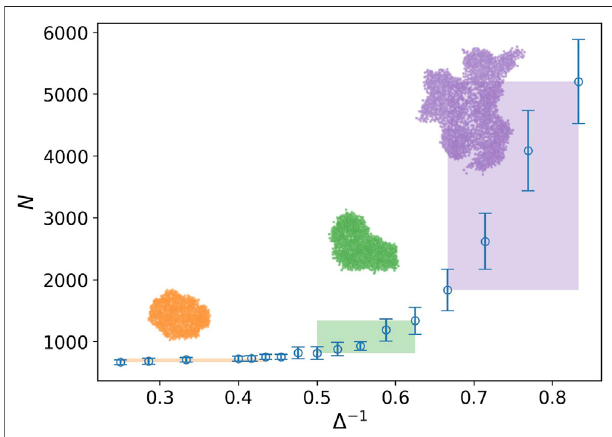
FIGURE 2 | Number of nodes against the inverse of attraction strength (blue circle), and the attraction range has a fi xed value, σ = 1.5. The error bars are the standard deviation of sampling over 20 simulation runs. Three regions with distinct behaviors are identi fi ed by the rectangles. The rectangle length approximately determines the domain of the phase and its height shows variation of the tumor size in that domain. The snapshot of a sample tumor is also illustrated for each region.